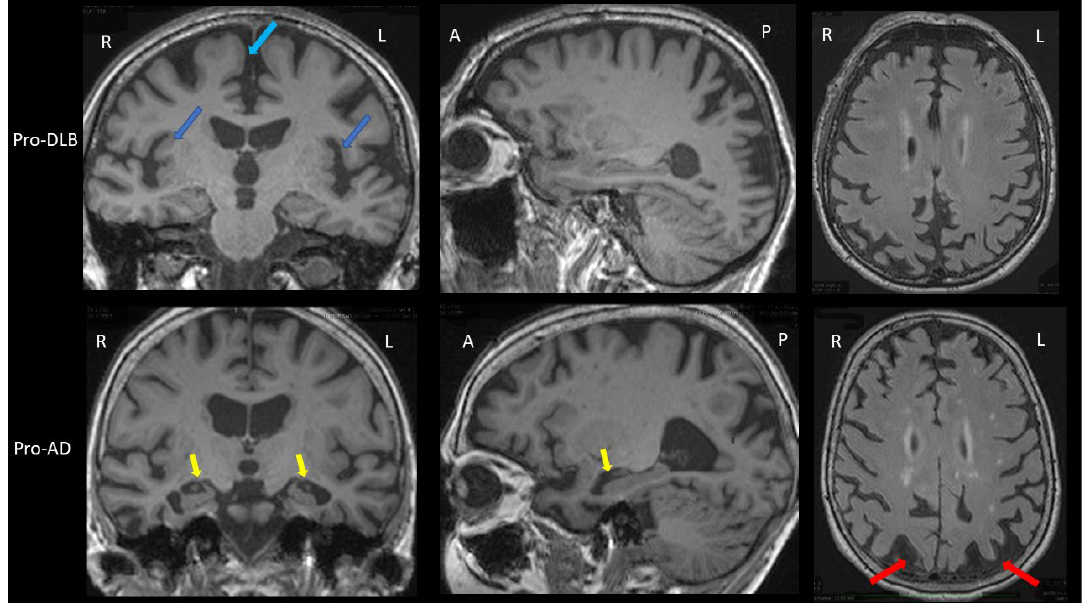
Figure 1. Brain MRI of patients with prodromal dementia with Lewy bodies and prodromal Alzheimer’s disease. Upper part: Brain MRI of a prodromal DLB (Pro-DLB) patient of 84 years with mild cognitive impairment (MMSE = 27/30), cognitive fluctuations, REM-sleep behavior disorder (RBD) and subtle Parkinsonism (UPDRS scale: rigidity 1/4 Froment’s maneuver, akinesia 1/4, attitude tremor). Top left image: T1 sequence, coronal section. The two dark blue arrows show the bilateral insular atrophy. Note the absence of hippocampal atrophy (Scheltens scale = 0/4) and the frontomesial atrophy (light blue arrow). Middle image at top: T1 sequence, sagittal section: absence of hippocampal atrophy and right parietal atrophy. Top right image: FLAIR sequence, axial section. There is no ischemic vascular lesion (Fazekas score = 0/3). Note the right parietal atrophy. Lower part: Brain MRI of a prodromal AD (Pro-AD) patient of 84 years old with mild cognitive impairment (MMSE = 29/30) with mainly verbal and visual memory storage disorders, and no Parkinsonism, no fluctuation, no RBD and no hallucination. Bottom left image: T1 sequence, coronal section. The two yellow arrows show the hippocampal atrophy (Scheltens scale = 3/4 for the left hippocampus and 2/4 for the right one). Note the subtle insular atrophy and frontomesial atrophy. Bottom middle image: T1 sequence, sagittal image. The yellow arrow shows the hippocampal atrophy. Note the parietal atrophy. Bottom right image: FLAIR sequence, axial section. The two red arrows show the bilateral parietal atrophy. There are few microvascular ischemic lesions as hypersignals (Fazekas score = 1/3). Comparison of the two patients shows greater hippocampal atrophy in the pro-AD patient, and greater insular atrophy in the pro-DLB patient.